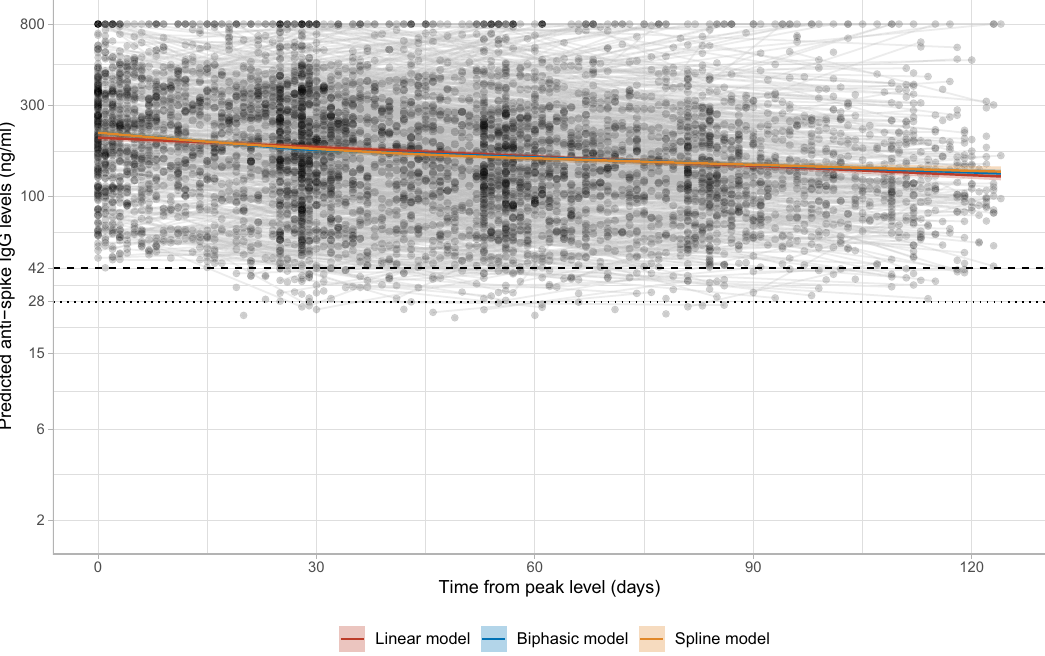
Fig. 4 Estimated mean trajectory of anti-spike IgG antibody levels and individual trajectories in 3271 participants in Class 1. The timing of the peak level 56 days after the fi rst positive swab is determined from the latent class mixed model. Estimated trajectories from three models are presented: the model assuming a linear decline in log 2 scale (red line), the biphasic exponential model (blue line), and the model using splines (orange line). For the biphasic model, knot is placed at 28 days. For the spline model, time is fi tted using natural cubic splines with internal knots at 30, 70 and boundary knots at 5, 110. The posterior mean and 95% credibility interval are shown. Black dashed line indicates the assay threshold for IgG positivity (42 ng ml − 1 ) and the dotted line indicates level associated with 50% protection against re-infection (28 ng ml − 1